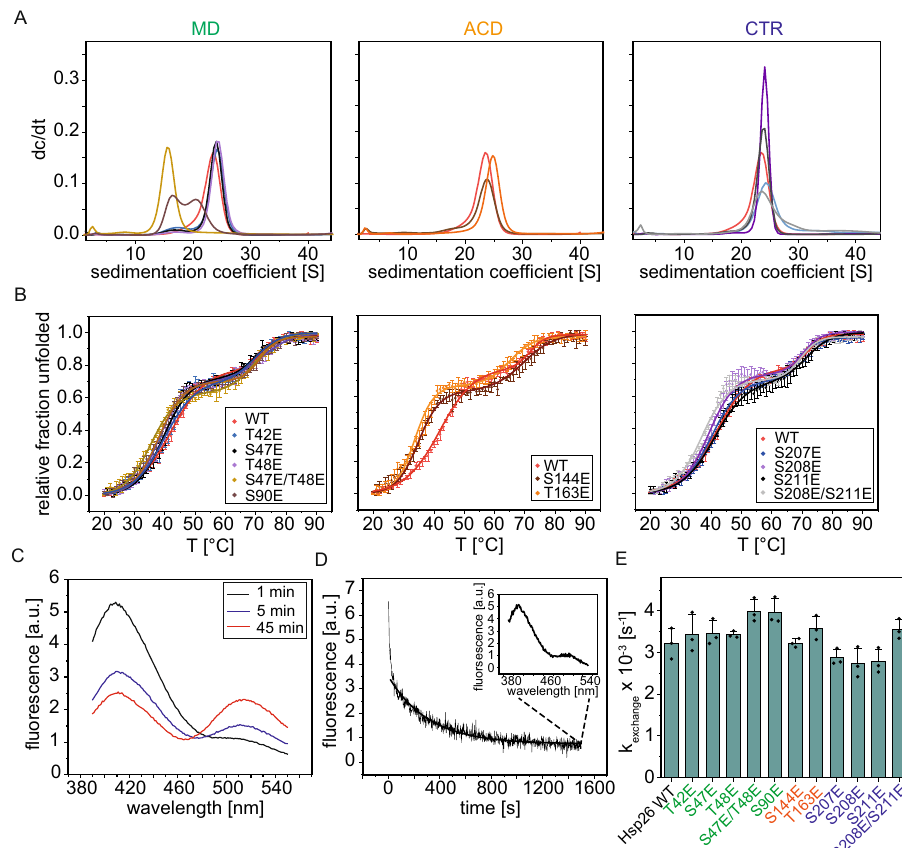
Fig. 2 Oligomers of phosphorylation-mimicking mutant dissociate at lower temperatures and tend to be smaller. A Determination of the oligomer size by AUC. The proteins were measured at a concentration of 23 µ M and 35,000 rpm (98,500 × g ) and 20 °C in PBS. Sedimentation was followed by UV absorption at 280 nm. Left panel: mutants of the NTR: WT: red, T42E: blue, S47E: black, T48E: purple, S47E/T48E: beige, S90E: brown. Middle panel: mutants of the ACD: S144E: brown, T163E: orange. Right panel: mutants of the CTR: S207E: blue, S208E: purple, S211E: black, S208E/S211E: gray. Runs with different chaperone concentrations are shown in Fig. S2A. HPLC runs are shown in Fig. S2B. B Thermal transitions of the proteins were measured in a Chirascan CD spectrometer at 218 nm in PBS. The protein samples (12.5 µ M) were heated from 20 to 90 °C. Mean values and the standard deviation are plotted. N = 3 independent experiments. The color code is the same as in A and is also shown in the graph panels. C Formation of Hsp26 FRET pairs. In all, 5 µ M AIAS and 5 µ M LYI-labeled Hsp26S5C were mixed and incubated at 40 °C. At the indicated time points, spectra were measured at an excitation wavelength of 330 nm. D Subunit exchange was measured by the addition of unlabeled Hsp26 to the Hsp26 FRET complex in 39-fold molar excess. The dissociation of the FRET complex was followed at 520 nm (excitation at 330 nm). Subunit exchange was measured at 40 °C for 1500 s. An exemplary dissociation curve obtained for the WT protein is shown. The small inset shows the spectrum after the subunit exchange. E Dissociation constants were determined by exponentially fi tting the dissociation curves. Mean values and the standard deviation ( N = 3 independent experiments) are shown. Two- sided Student ’ s t tests were performed to check whether the changes were statistically signi fi cant. Only the changes observed for the S47E/T48E mutant were signi fi cantly different from the WT ( p =